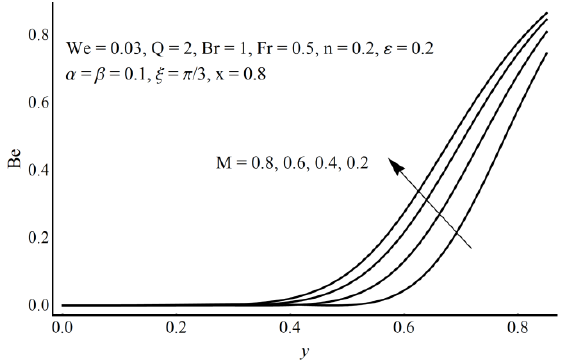
Figure 16. Effect of M on the Bejan number. Figure 16. E ff ect of M on the Bejan